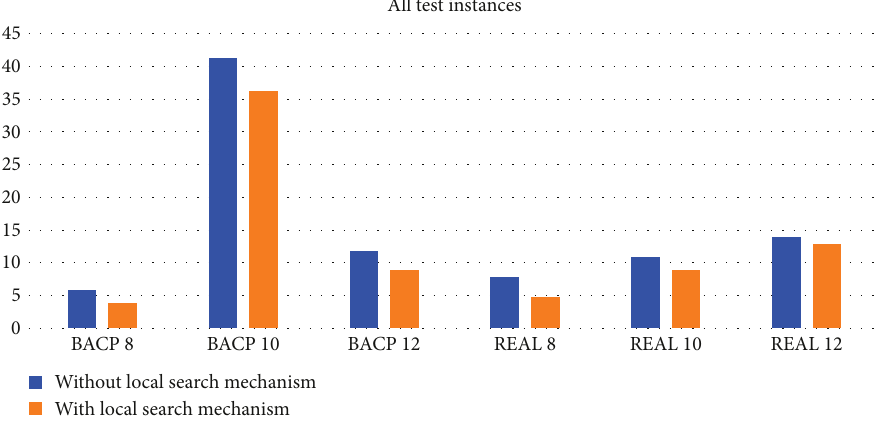
F IGURE 19: Comparison of all test instances with LSM and without